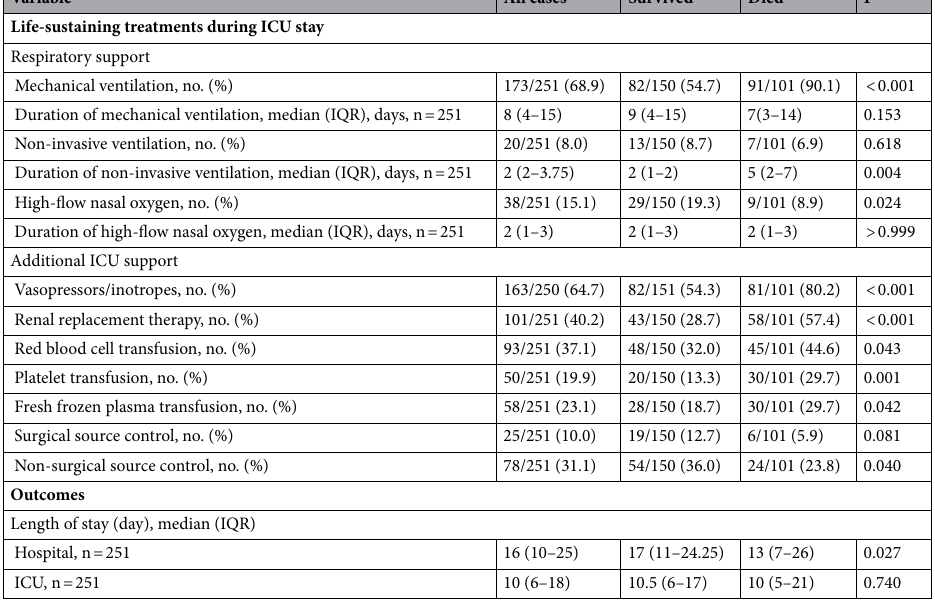
Table 6. Life-sustaining treatments during ICU stay and outcomes according to hospital survivability of patients with sepsis. ICU intensive care unit, IQR interquartile range, no. number. a Comparison between survived and died patients with